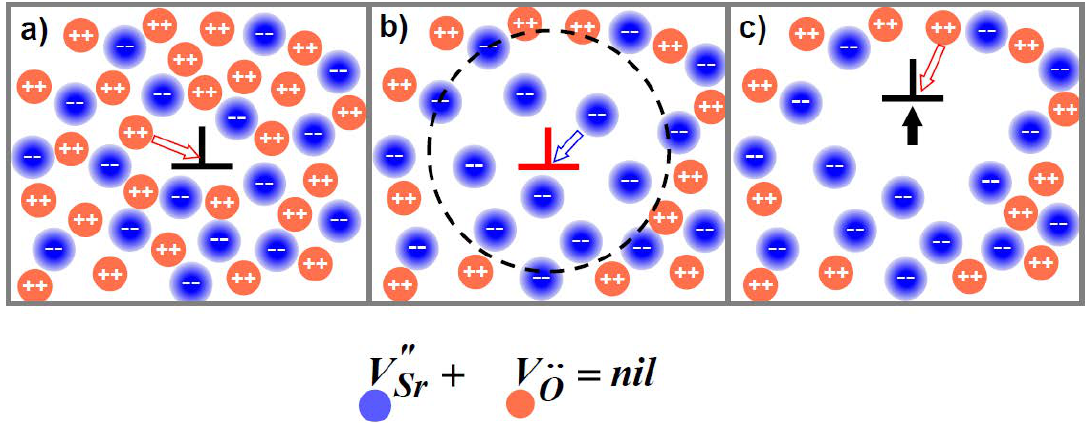
Figure 4. Illustration of dislocation climb in SrTiO 3 crystal according to a scenario from Hirel et al. [106]. In this scenario, ( a ) the core of dislocation is originally in a neutral state, i.e., both points of gravity of the positively charged and negatively charged cloud of vacancies overlap. Because positively-charged oxygen vacancies migrate faster than cation vacancies (here V Sr ) towards the dislocation, the dislocation becomes charged; ( b ) After absorbing neighboring oxygen vacancies, this leads to a positive charging of the dislocation (red) and development of a oppositely charged space-charge region (dashed line), where only cation vacancies remain and form the so-called Debye–Hückel cloud. In this situation, cation vacancies do migrate slowly towards the dislocation core; ( c ) After absorbing cation vacancies, the dislocation then climbs and becomes again attractive to oxygen vacancies. Adapted from [106].